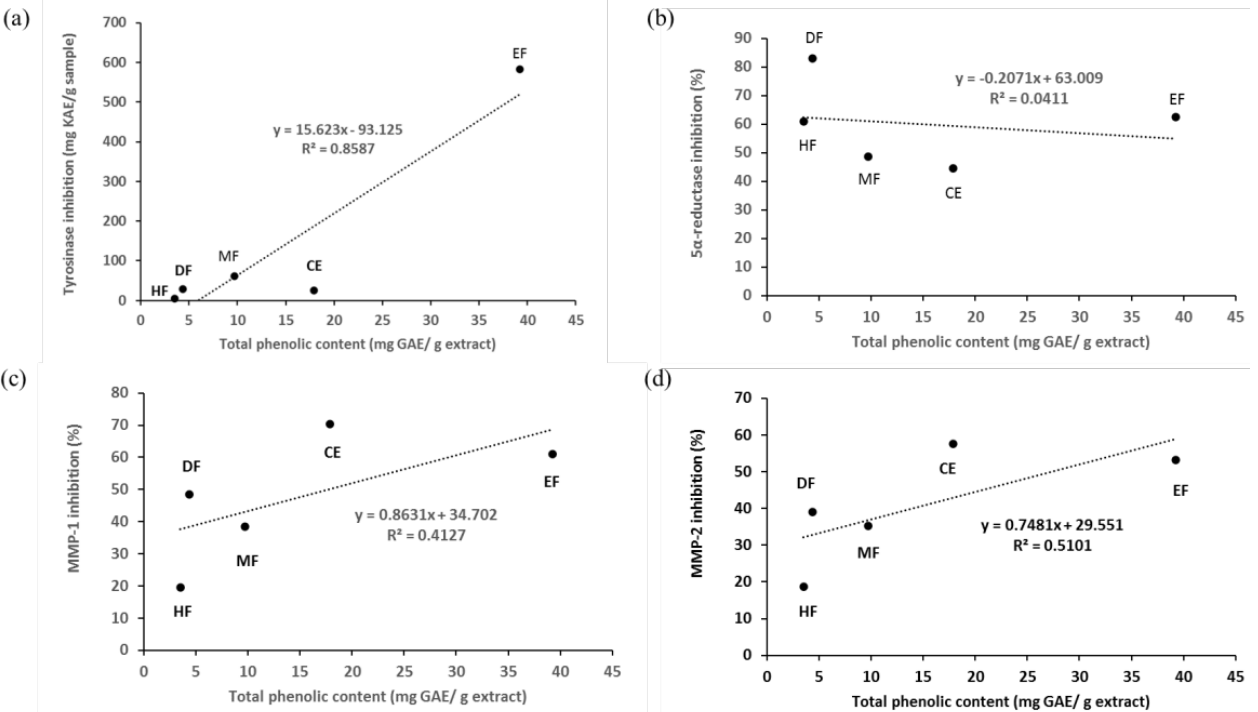
Figure 6. Relative scatter plot of total phenolic content and inhibition activities of crude extract (CE), hexane fraction (HF), dichloromethane fraction (DF), ethyl acetate fraction (EF), and methanol fraction (MF); ( a ) anti-tyrosinase activity (regression p -value = 0.0236); ( b ) anti-5 α -reductase activity (regression p -value = 0.7437); ( c ) anti MMP-1 activity (regression p -value = 0.2424); and ( d ) anti MMP-2 activity (regression p -value =